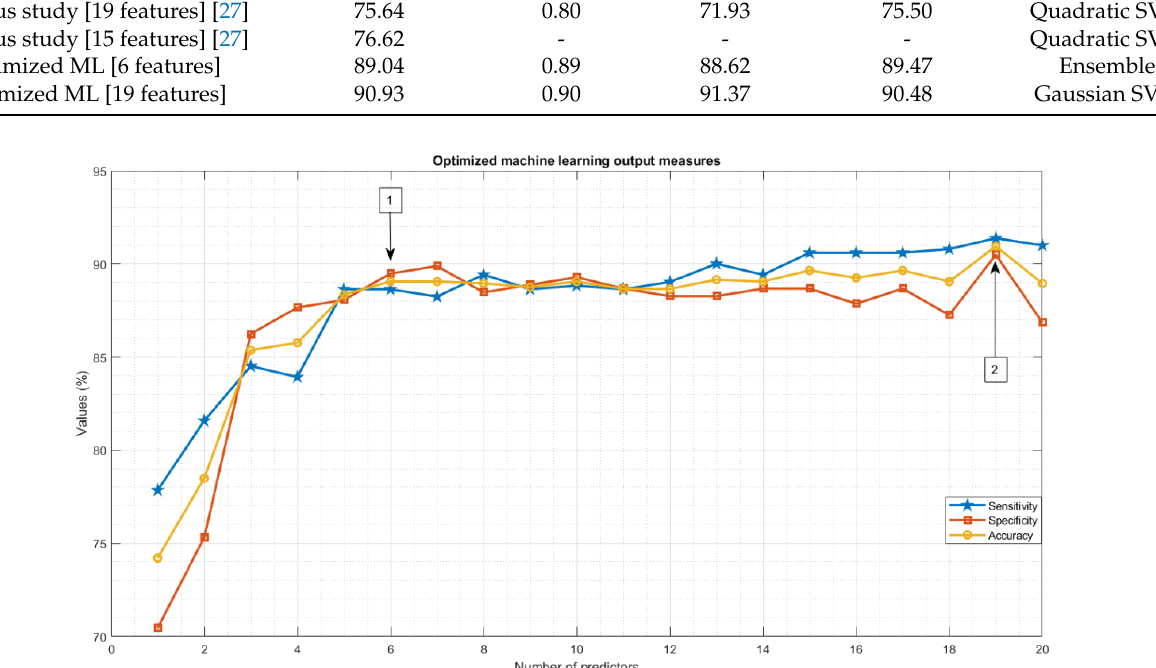
Figure 5. Optimized machine learning results for ranked twenty microstate features. Number (1) shows the best-fitted model results acquired for using six ranked features. Number (2) shows the highest output measures when using 19 input features.